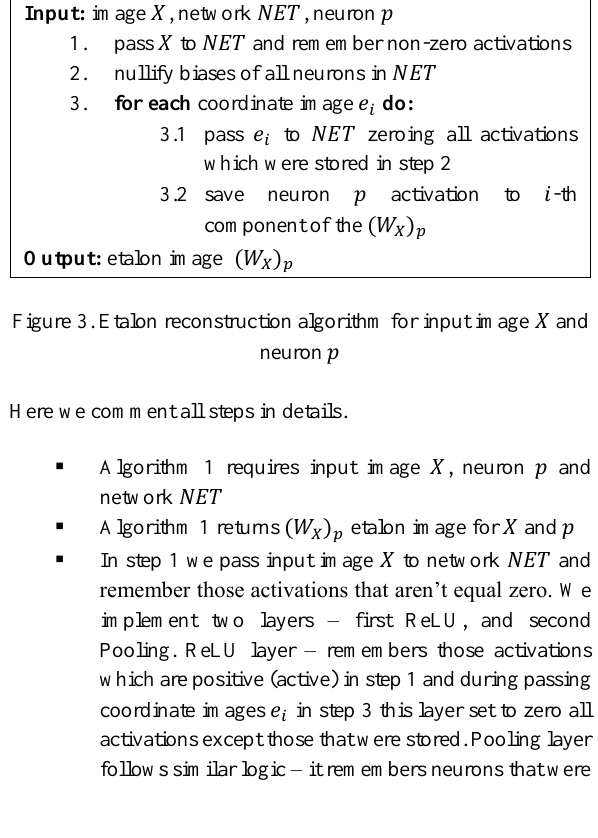
Algorithm 1 . Etalon reconstruction for input image 𝑋